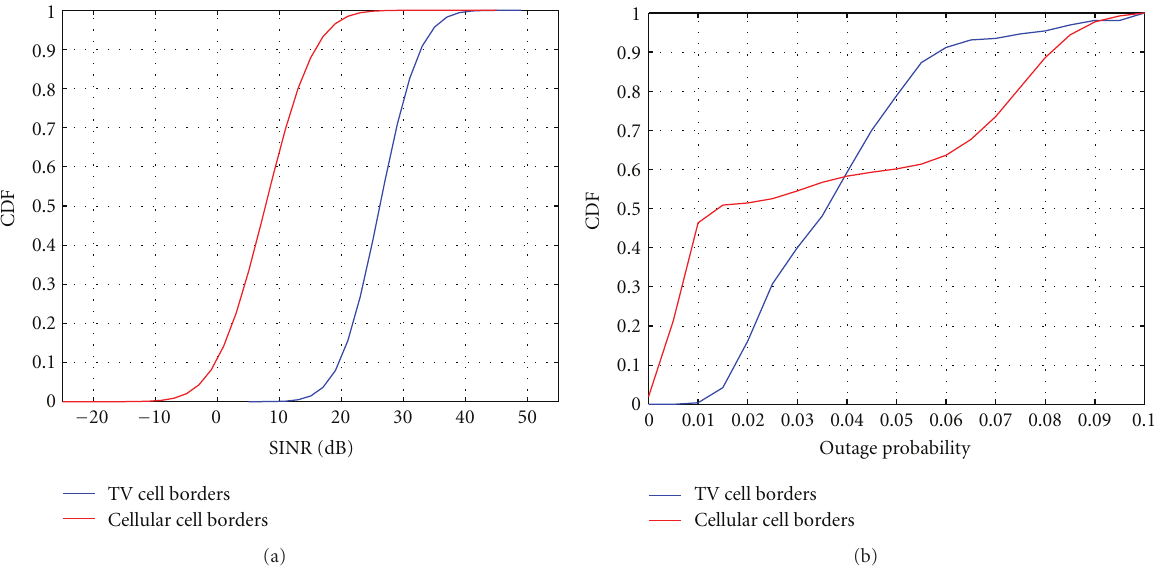
Figure 9: (a) SINR distribution at the TV test points and the cellular cell borders. (b) Distribution of the outage probability at the TV test points and the cellular cell borders.